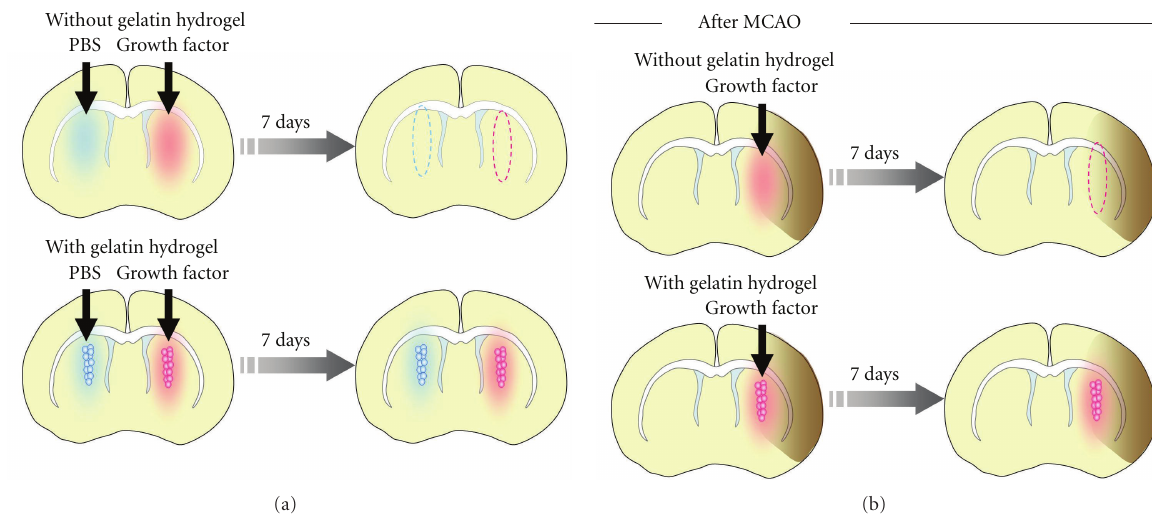
Figure 1: Study design. Schematic illustration of experiments performed to test the e ff ects of growth factors released from gelatin hydrogel on neurogenesis in the SVZ. E ff ects of growth factors injected into normal (a) and injured brains 11 days after MCAO (b) with or without gelatin hydrogel on the number of new neurons in the SVZ and injured striatum, respectively, were compared 7 days after the injections. Blue and pink circles represent gelatin hydrogel